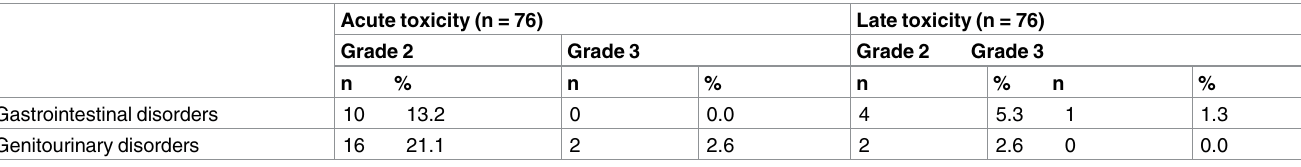
Table 2. Treatment related acute and late toxicities (CTCAE